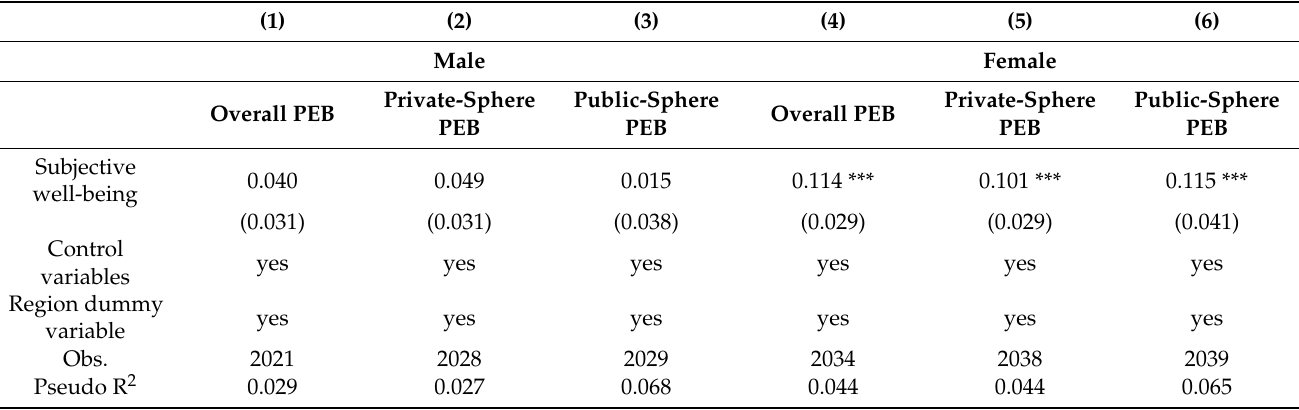
Table 6. The influence of subjective well-being on the PEB of rural residents by